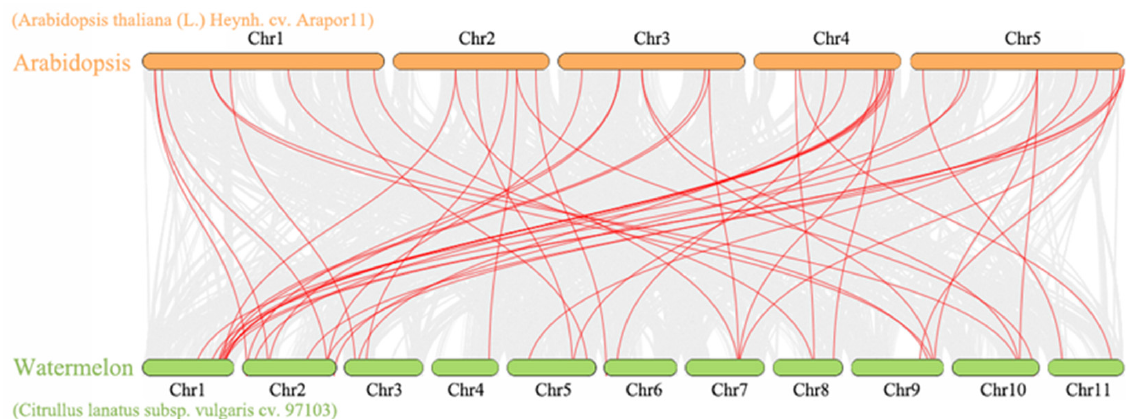
Figure 2. Comparative linear relationship of PRXs in watermelon and Arabidopsis.